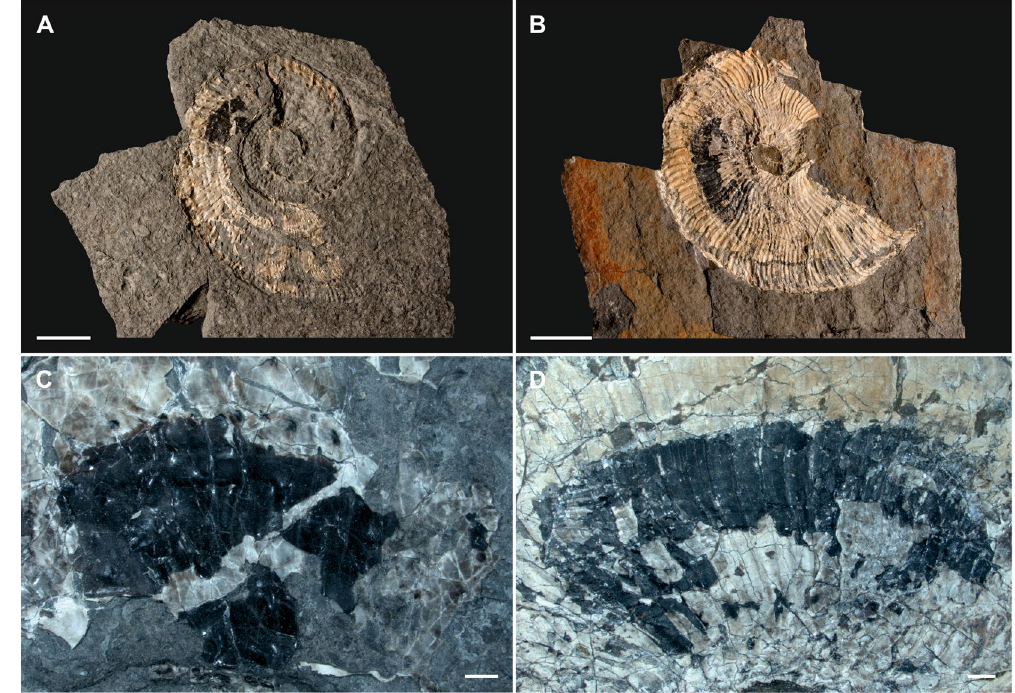
Figure 4. Ammonoid members and soft body remains of the Lower Carnian (Upper Triassic) Polzberg palaeobiota. ( A ) Adult Austrotrachyceras minor , positive, lateral view, note black mass in innermost posterior third of body chamber, NHMW 2021/0123/0137; ( B ) Adult A. minor , lateral view, with black mass in posterior third of body chamber, fatally bitten at ventral, NHMW 2021/0123/0138; ( C ) A. minor , magnification of black mass in ( A ), NHMW 2021/0123/0137; ( D ) A. minor , magnification of black area in ( B ), NHMW 2021/0123/0138. Scale bars: ( A , B ) 10 mm, ( C , D ) scale bar: 1000 μm. Prepared by AL using CorelDRAW X7; www. corel draw.